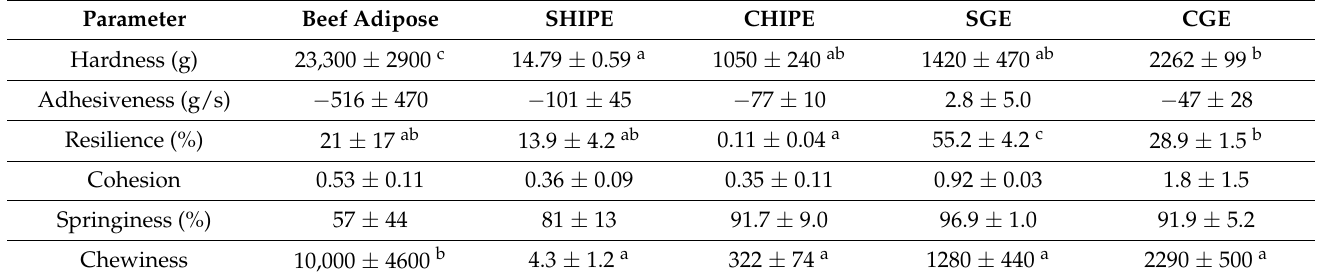
Table 1. Texture profile analysis of beef adipose tissue, soybean oil HIPEs (SHIPE), coconut oil HIPES (CHIPE), soybean oil gelled emulsions (SGE), and coconut oil gelled emulsions